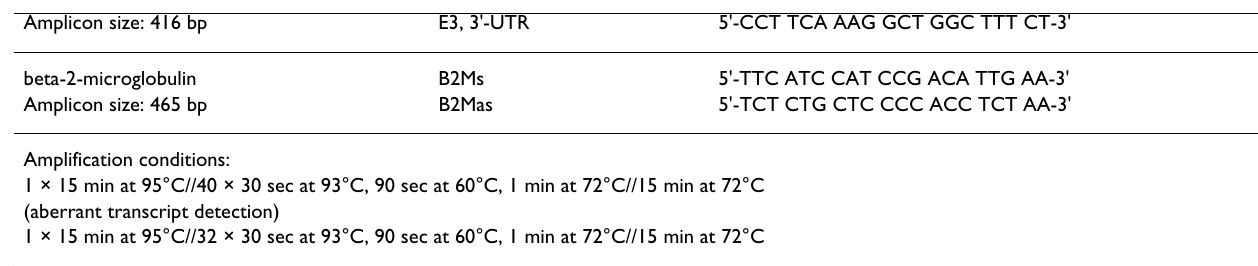
Table 1: Oligonucleotide primers for amplification and sequence analysis of FGF10 in transcript and genomic DNA, and quality controls.